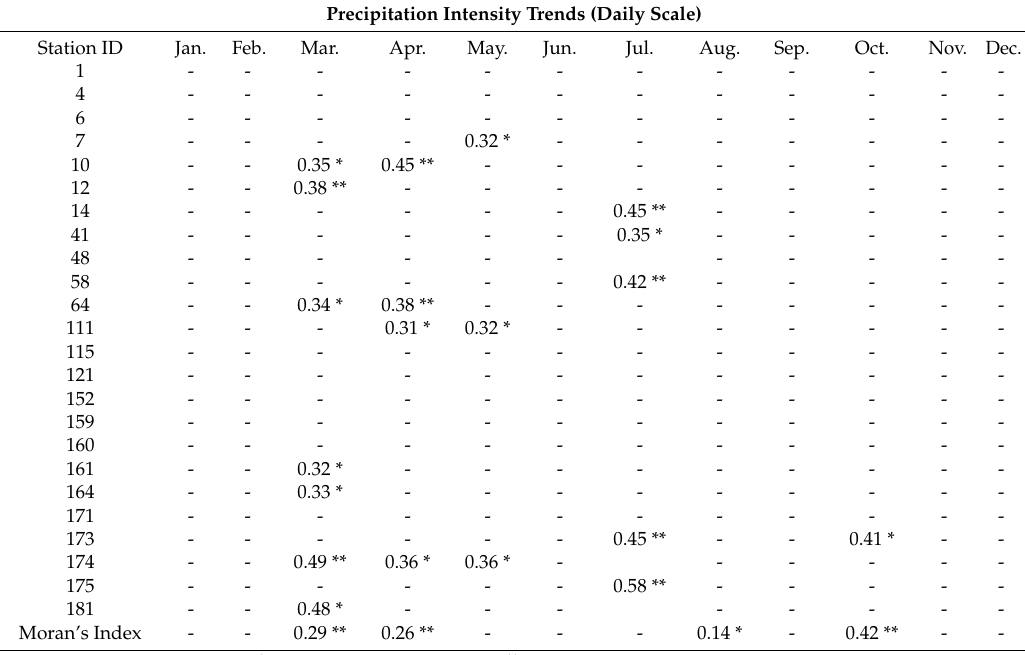
Table A2. Kendall’s Tau values for monthly precipitation intensity trends using daily scale data.